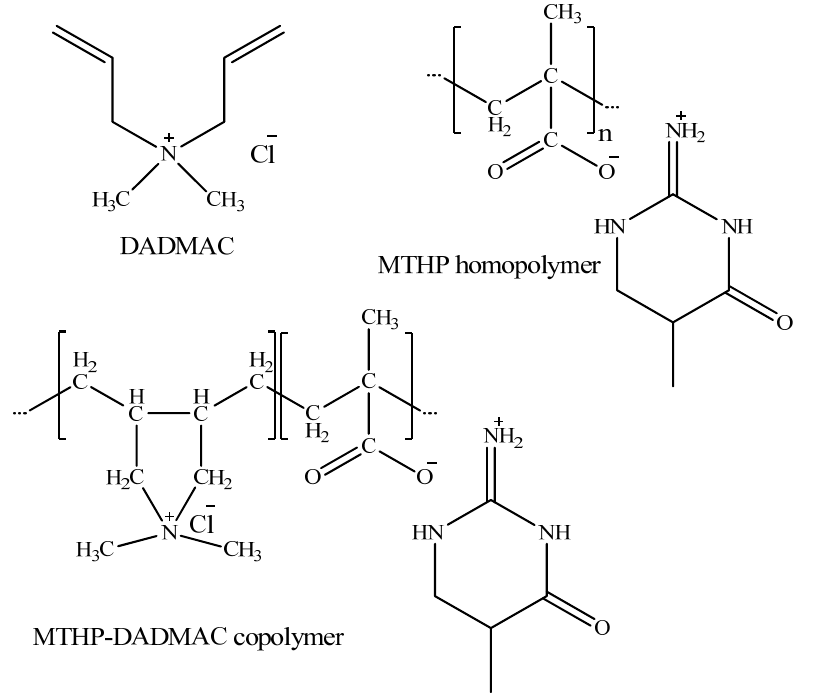
Scheme 5. DADMAC and MTHP polymerization